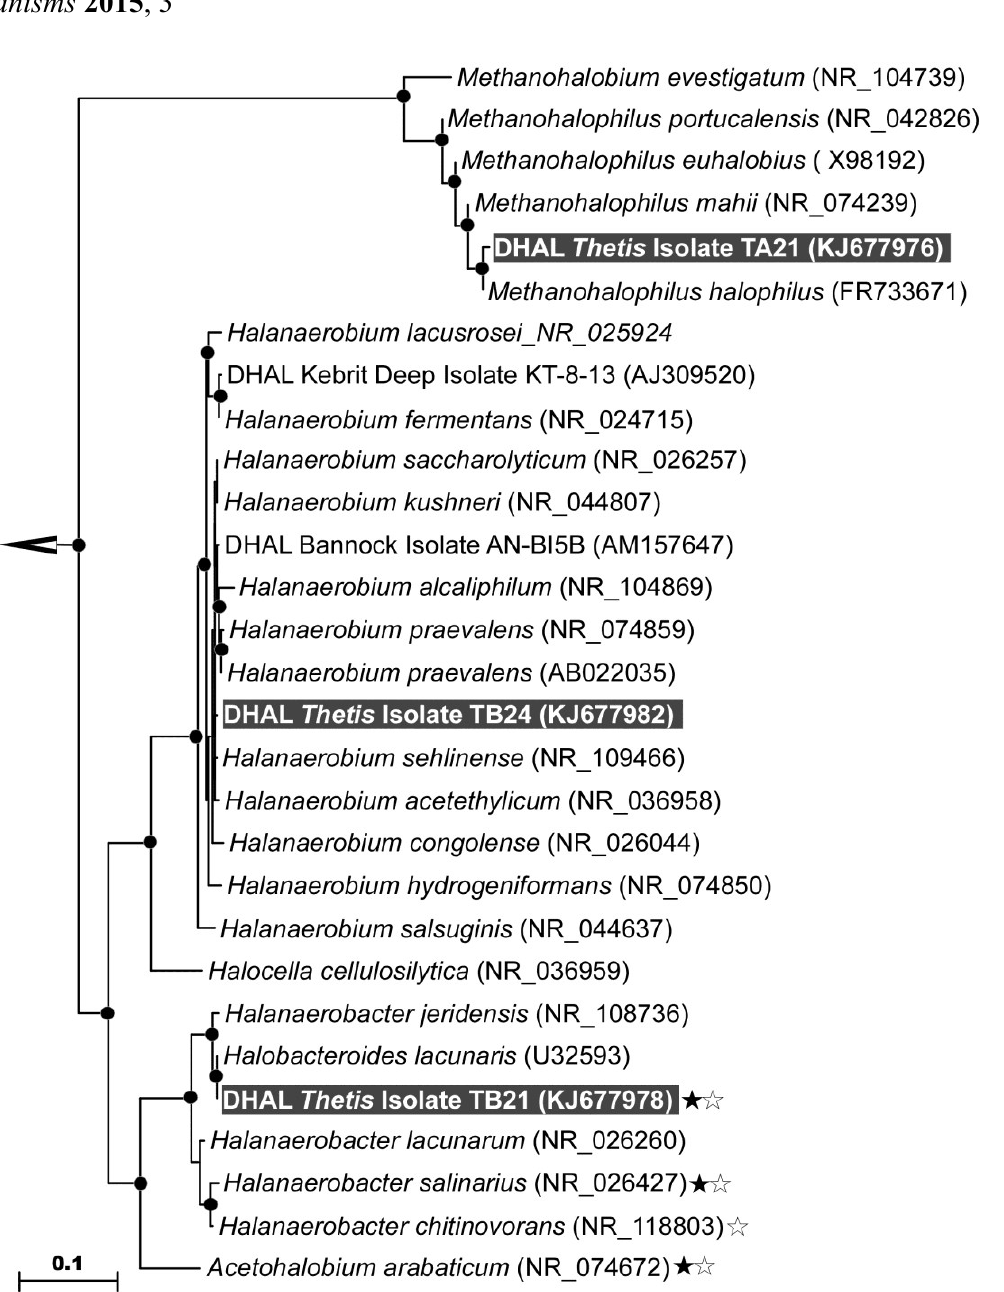
Figure 2. Phylogenetic affiliation of clones and isolates of Thetis GB-degrading enrichment. Neighbor-joining analysis using 1000 bootstrap replicates was used to infer tree topology. The scale bar represents 10% of sequence divergence. Bootstrap values (>75%) are indicated at branch points as closed circles. Sequences obtained in this study are evidenced by gray background. Sequences of organisms capable of reductive degradation of GB with either hydrogen or serine (Stickland reaction) are indicated by black and white stars,